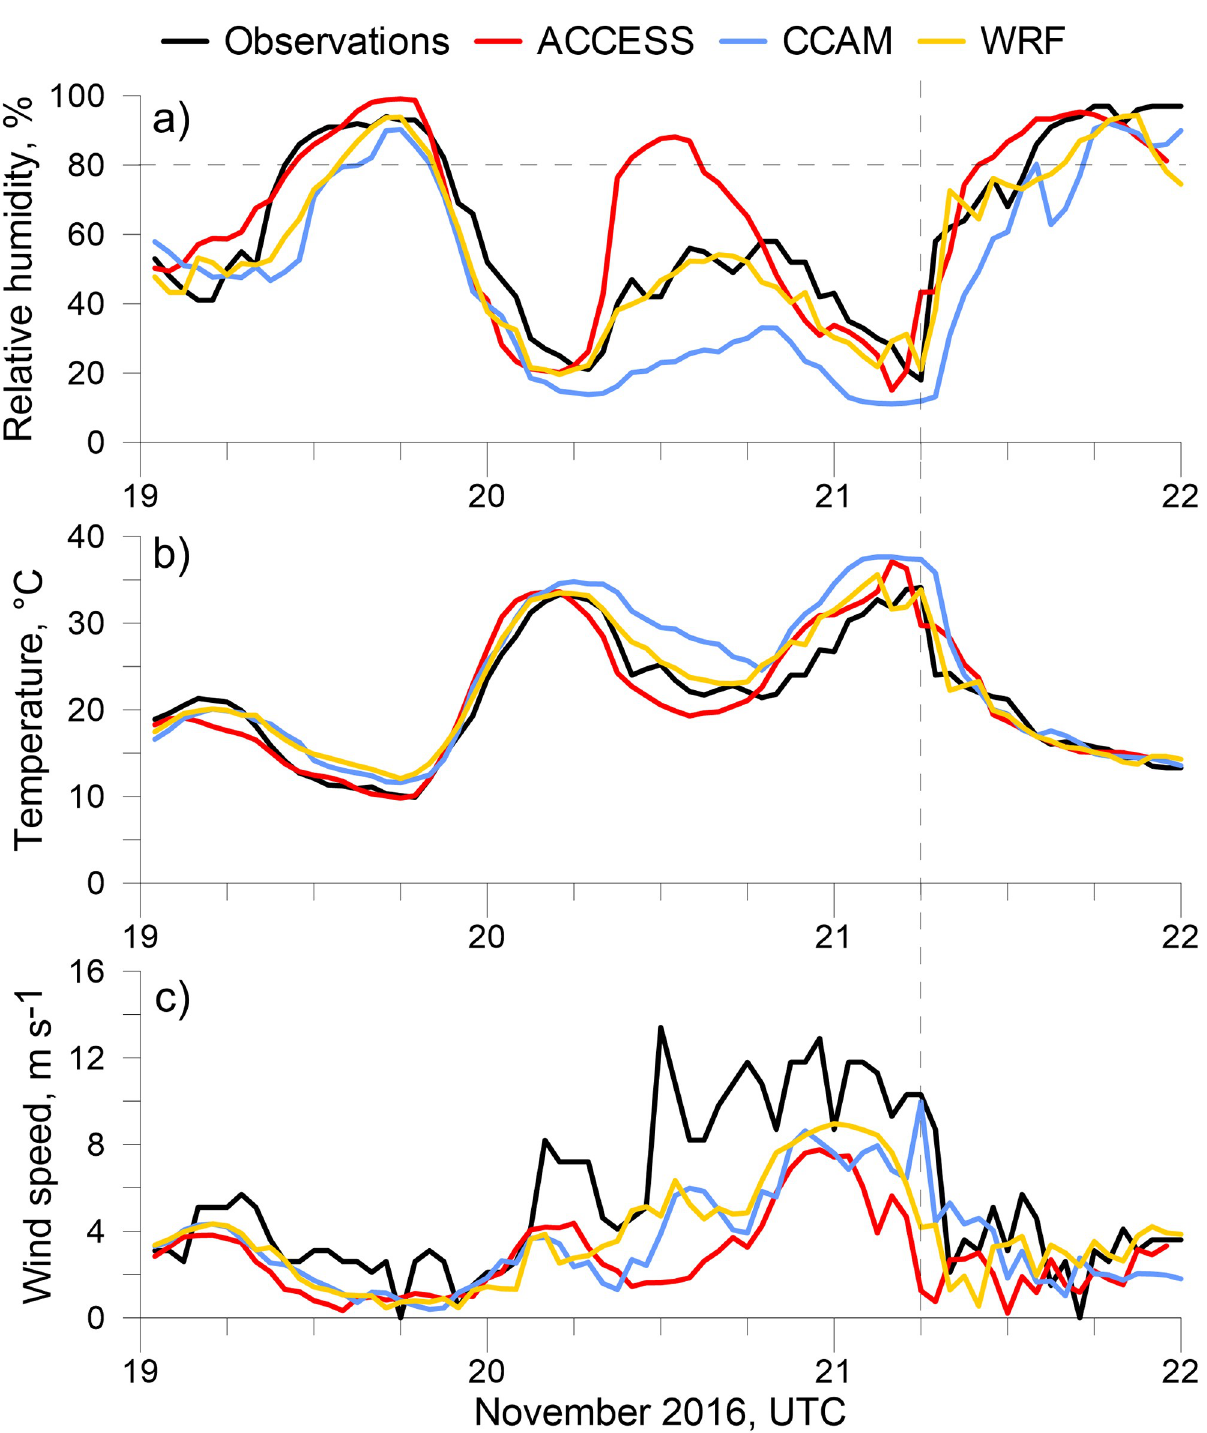
Fig 3. Time series in (a) 2m relative humidity (b) 2 m temperature and (c) 10 m wind speed at Melbourne Olympic Park, the closest automatic weather station to the pollen observation site. The vertical dashed line indicates the time of the storm, the horizontal dashed line indicates the 80% RH